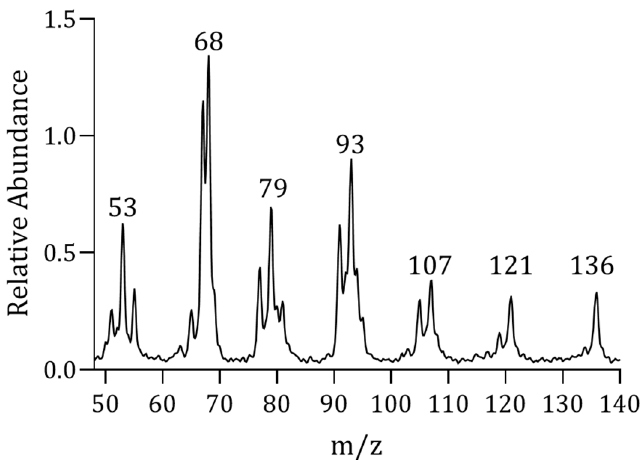
Figure 3. PY-MIMS spectrum of EUG.